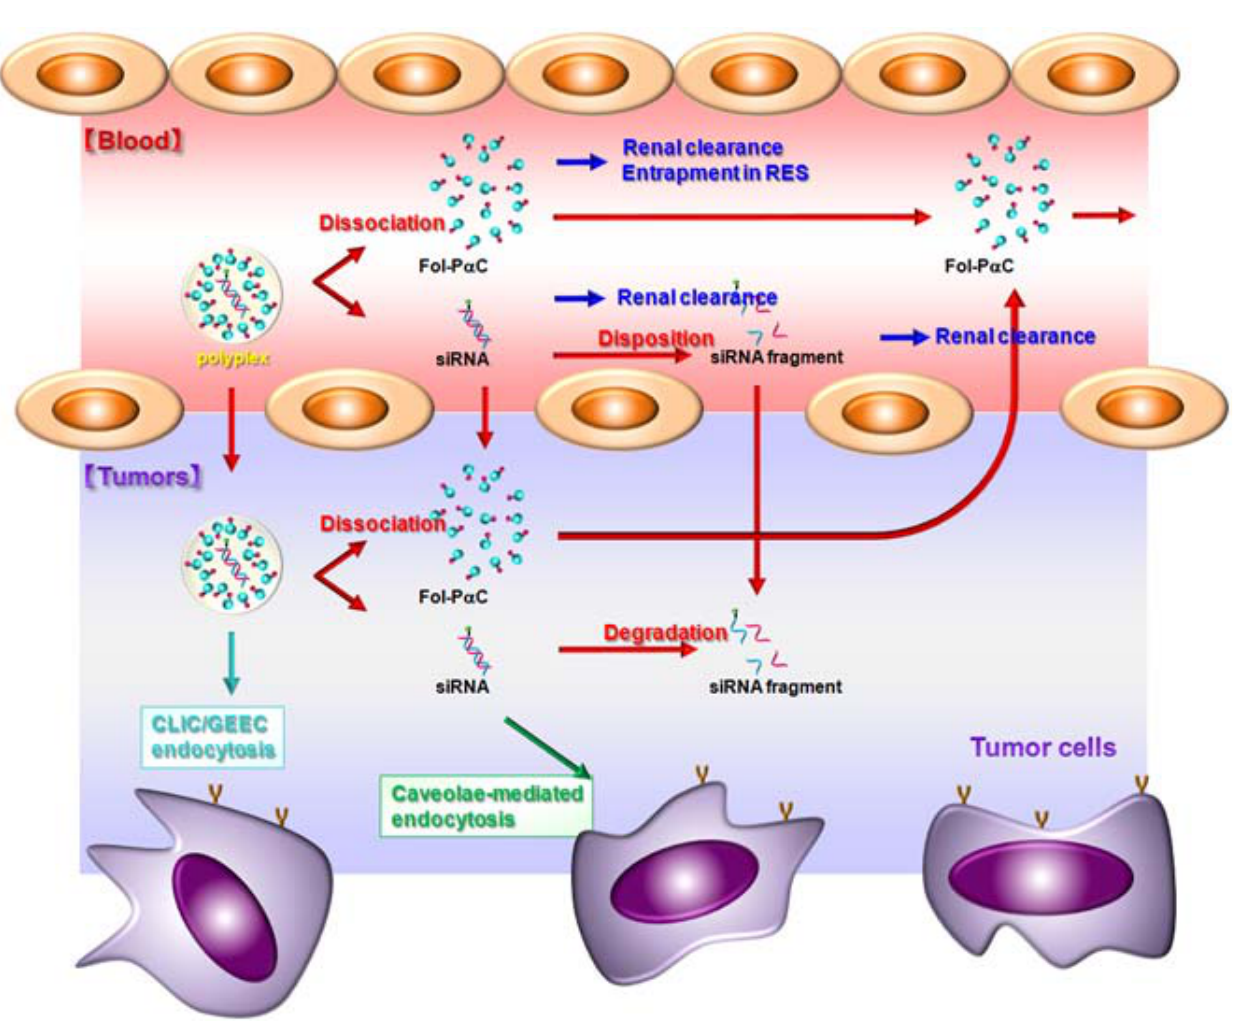
Figure 4. Proposed mechanisms for in vivo tumor cells-selective RNAi effects by Fol-P α C (G3, DSF